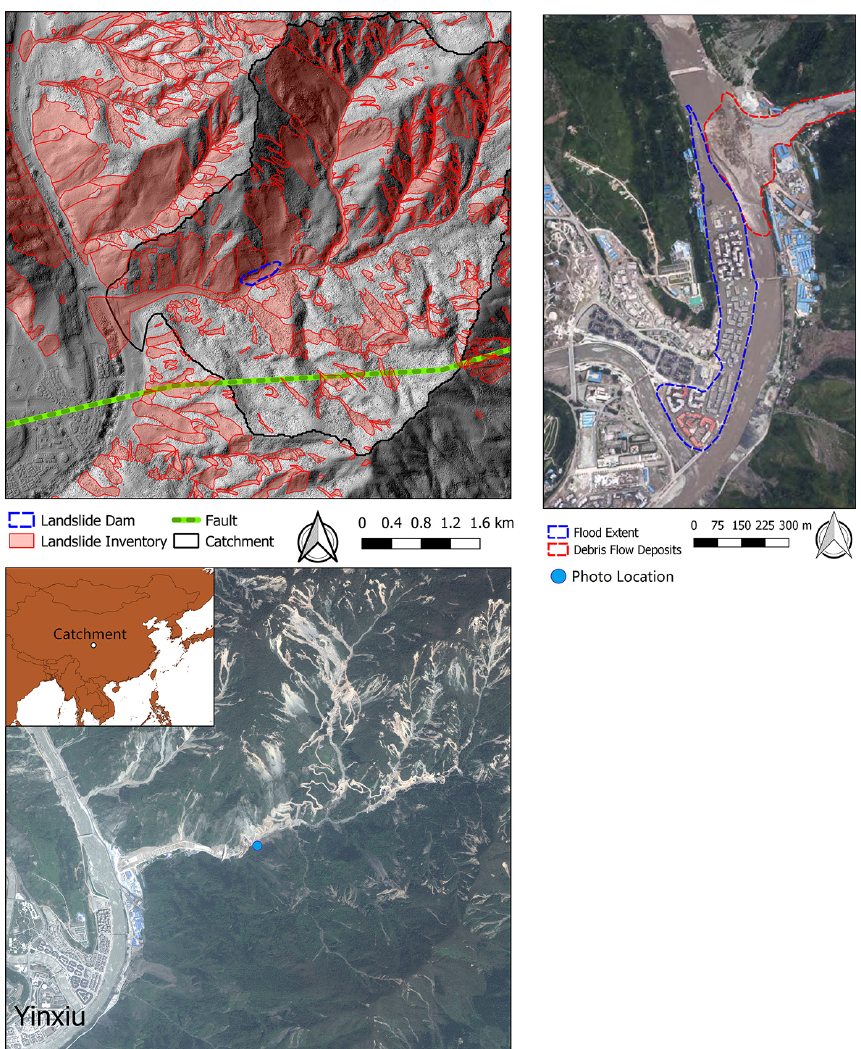
Figure 4. An overview of the Hongchun watershed: (top) hillshade image with co-seismic landslide map from Tang et al. (2016); (bottom) post-event natural color composite from the Pléiades satellite showing the situation in 2017. The construction of massive debris flow mitiga- tion works in the outlet of the watershed is clearly visible, as is the continued mass movement activity 9 years after the earthquake. (Right) Aerial image of the 2010 debris flow blocking the Min River and causing flooding in the town of Yinxiu. Top-right imagery from PLEIADES ©CNES 2010, distribution Airbus DS, and bottom imagery from PLEIADES ©CNES 2017, distribution Airbus DS.